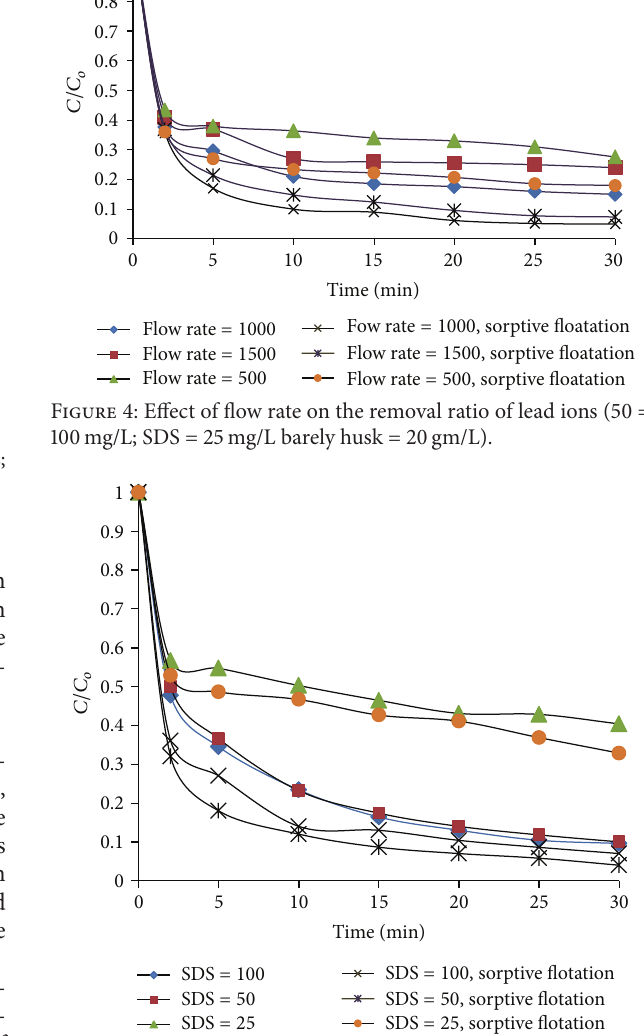
Figure 5: Effect of SDS surfactant on the removal ratio of lead ( 𝐶 𝑜 = 50 mg/L; pH = 8; 𝑄 = 1000 mL/min; barley husk = 20